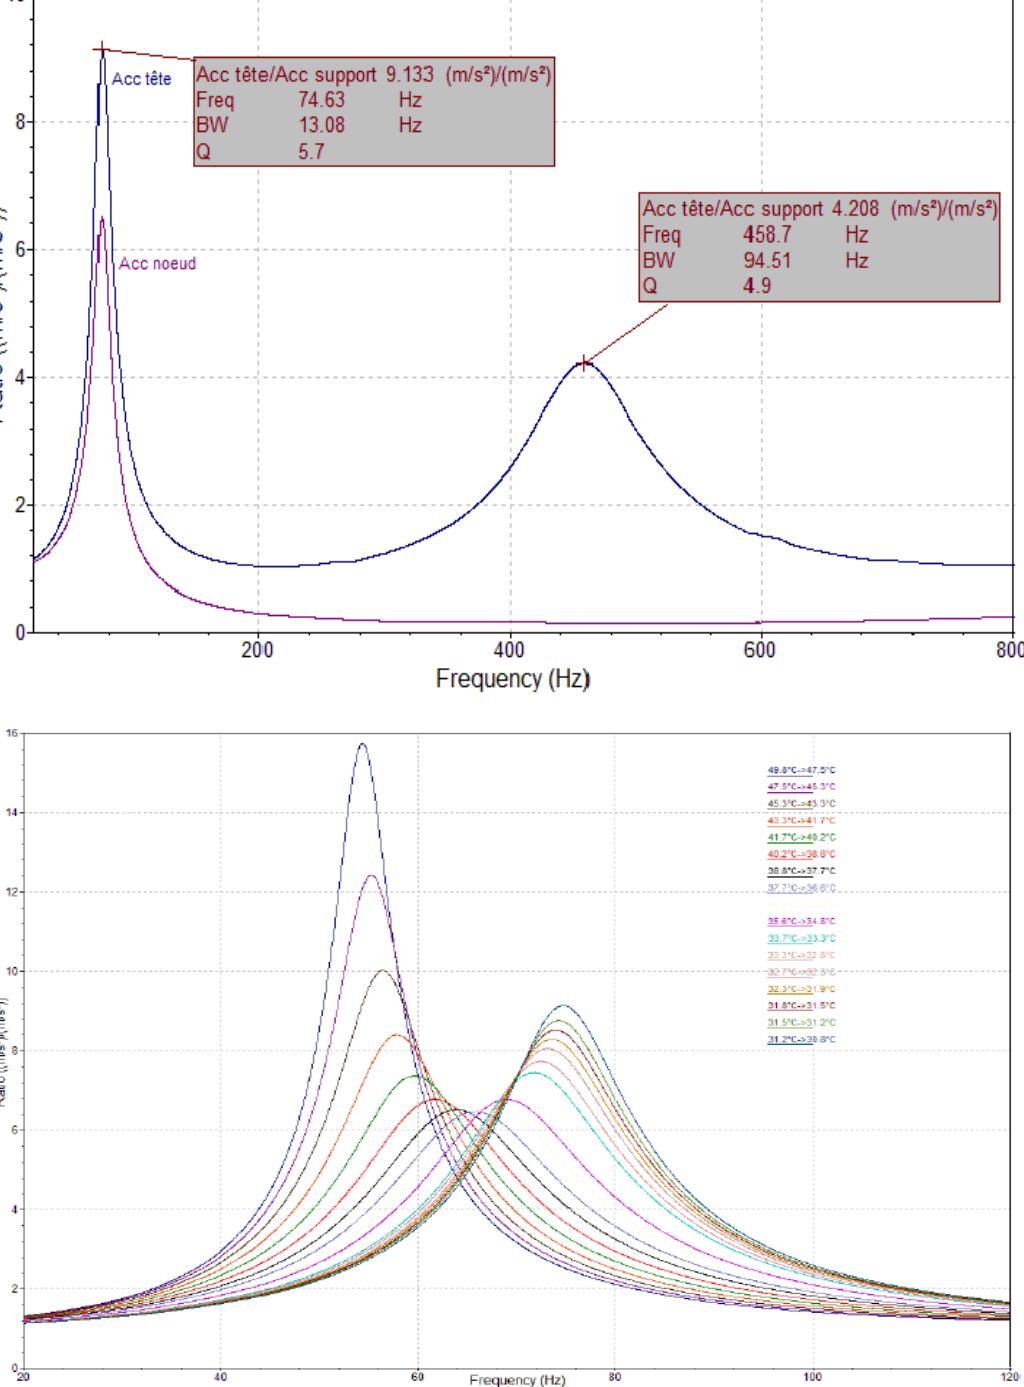
The comparison with the theoretical values is presented on Figure 2a for the fundamental frequencies, and on Figure 2b for the damping. It can be noticed a good qualitative and quantitative agreement. The damping seems quite well assessed. The experimental frequency actually lies in between the two limit frequencies corresponding to the bi-layer and monolithic Kirchhoff plate, however the experimental value is systematically lower than the theoretical one. A very likely explanation of this mismatch is that the clamping condition was not exactly reached despite the